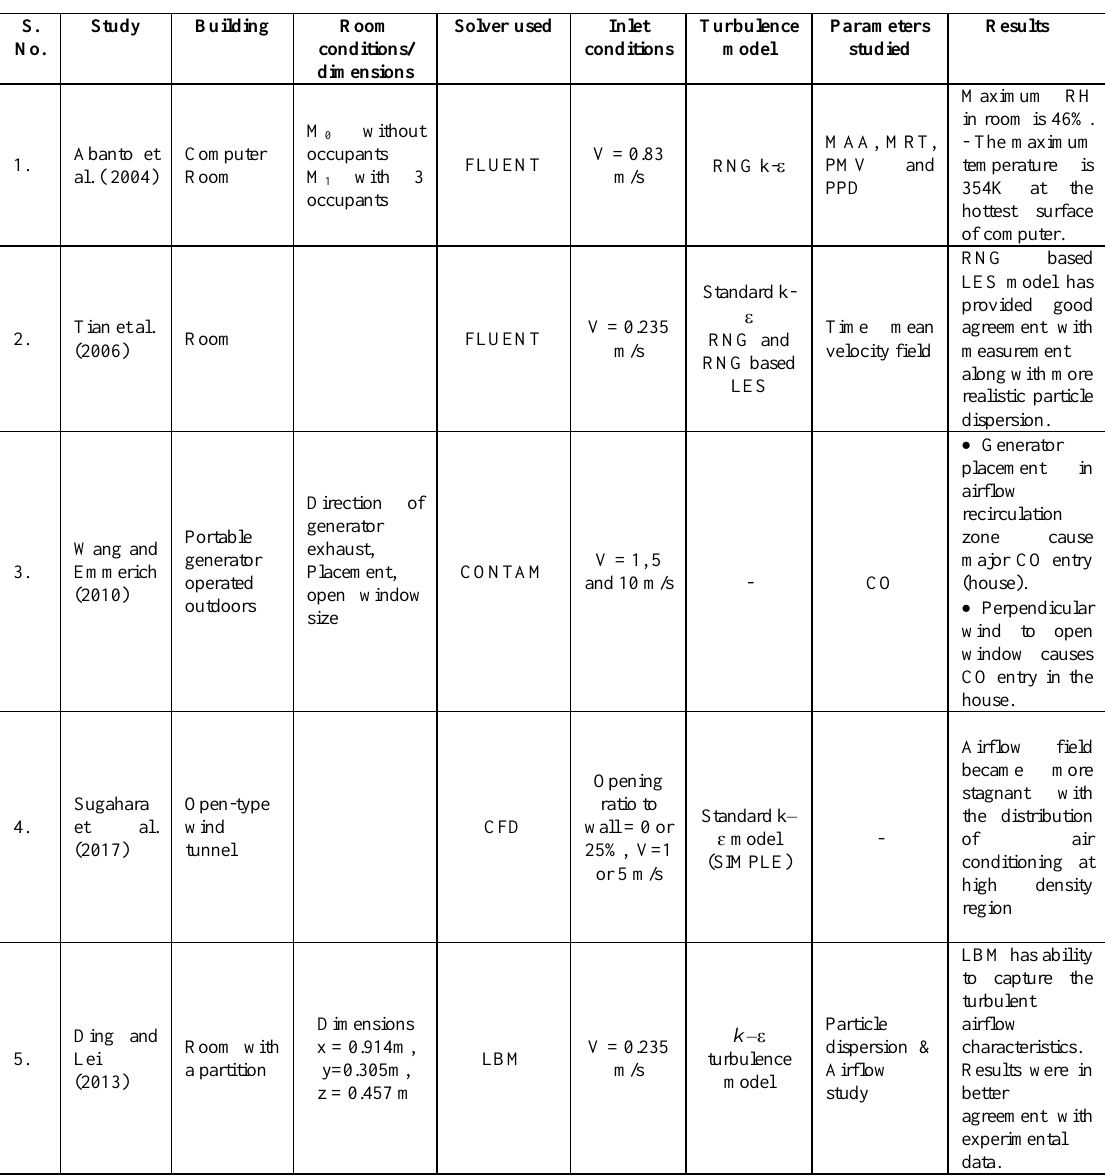
Table 1 Computational study on various type of built